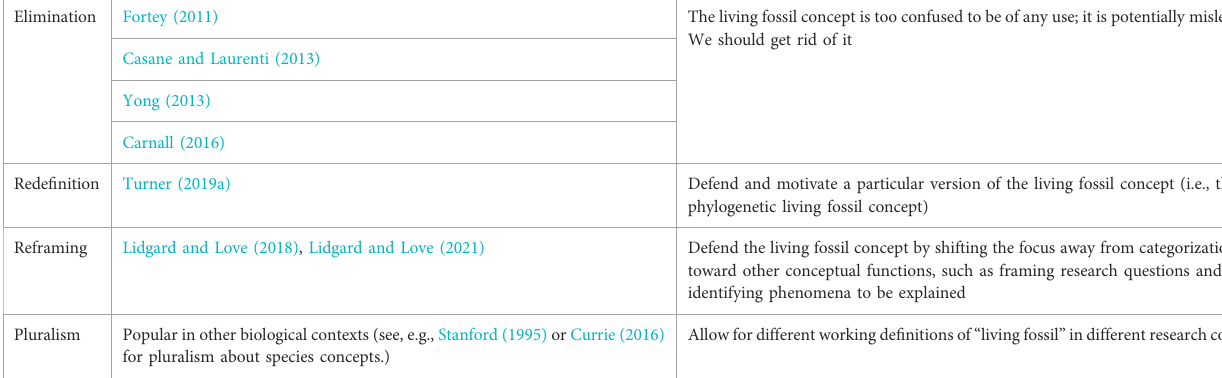
TABLE 1 Possible views about the status of the living fossil